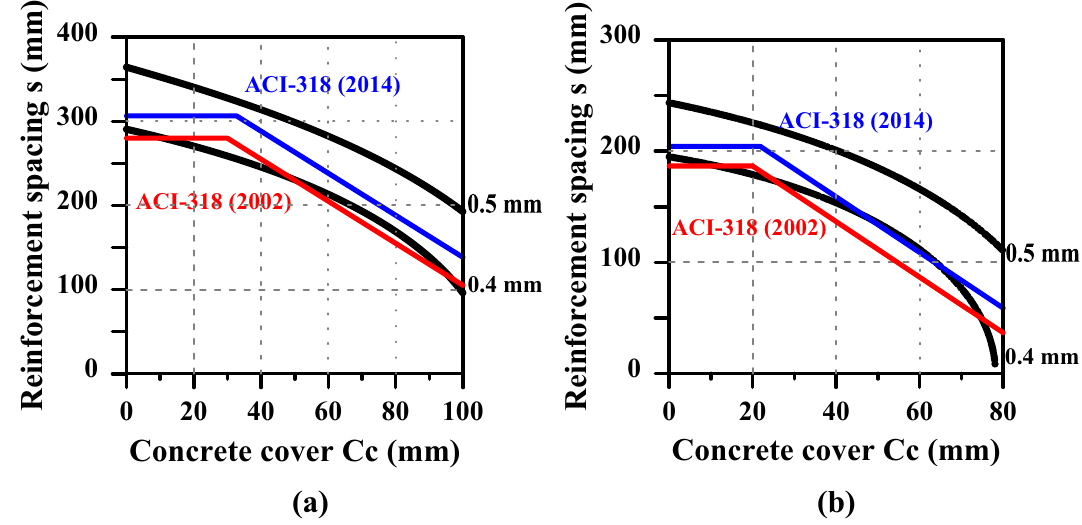
Fig. 4 Design equations in ACI 318-02 and ACI 318-14 for the flexural crack width control a f s = 0.4f y and b f s = 0.6f y .